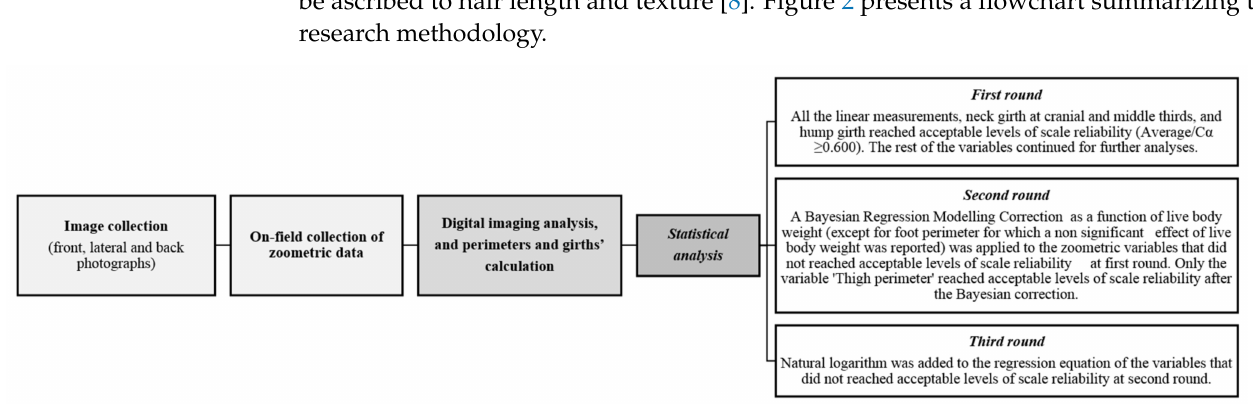
Figure 2. Flowchart summarizing the methodology proposed in the present study.